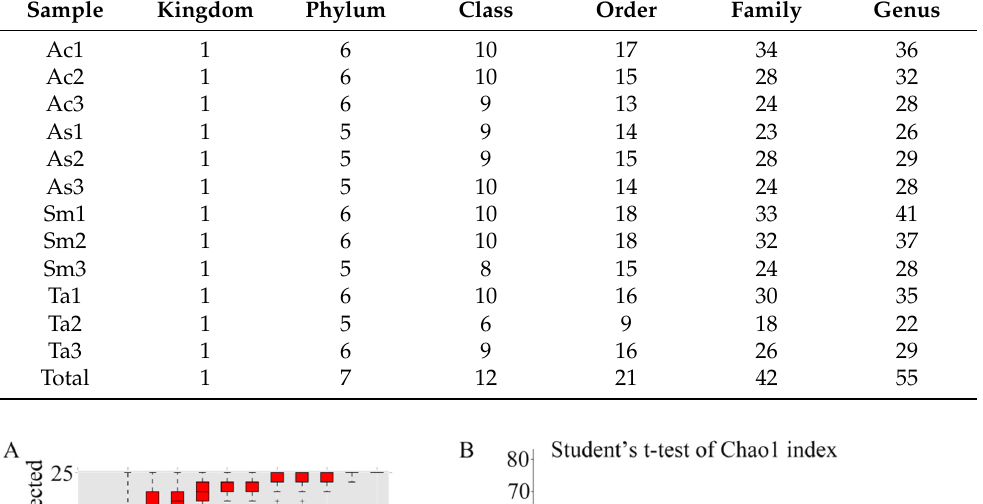
Table 2. Species statistics table of each grade of the sample. Sample